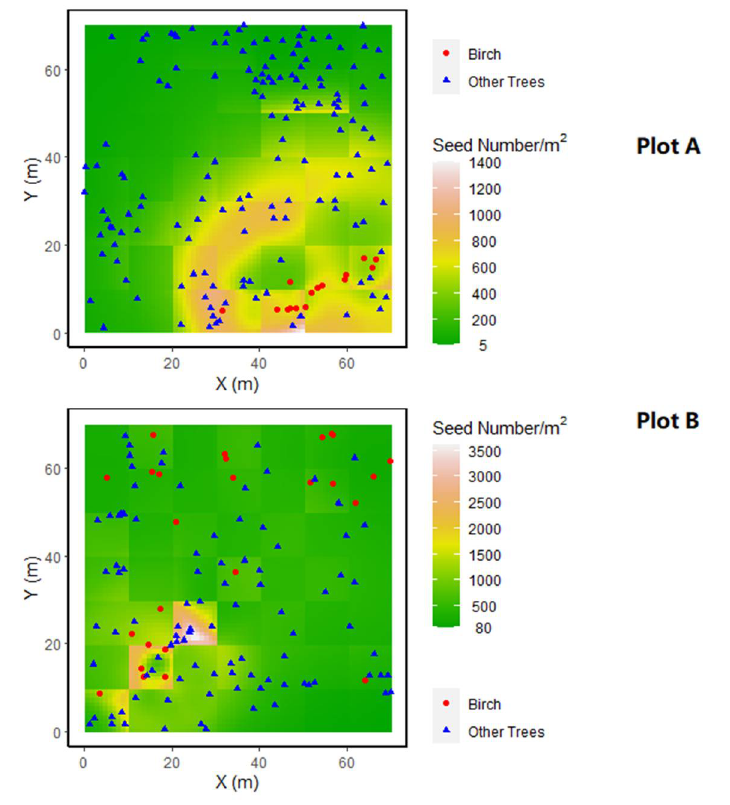
Figure 4. Predicted distribution of seed number per m 2 of plot A (top) and plot B (bottom) by the best model with locations of trees. Please note the minimum predicted seed number is not zero.